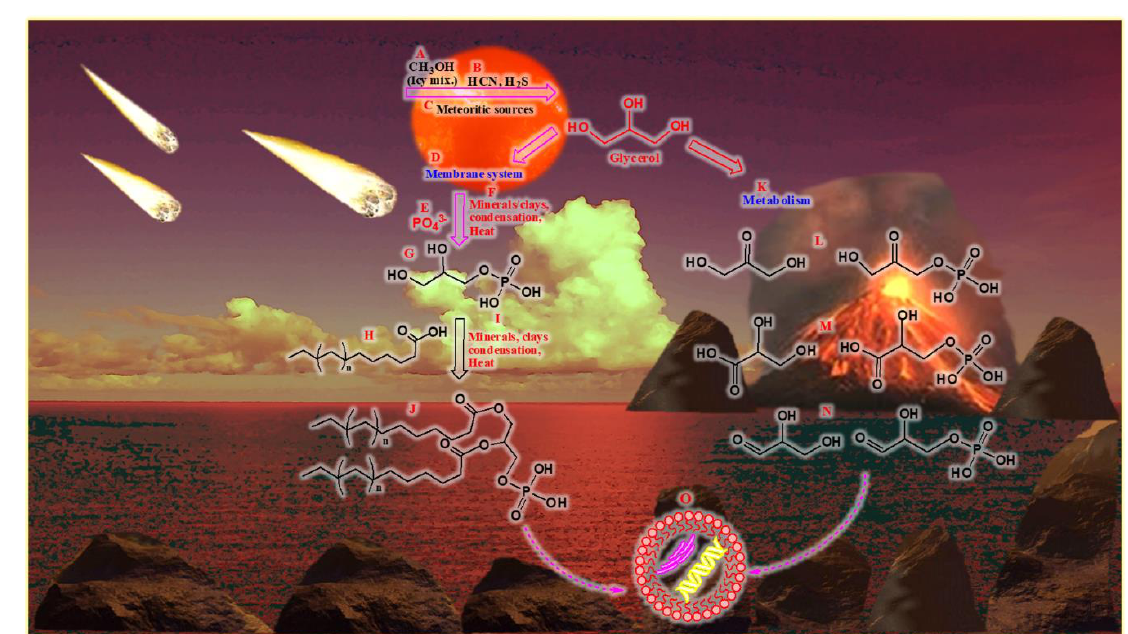
Figure 15. A schematic description of the plausible role played by glycerol during prebiotic synthesis and chemical evolution: ( A , B ) the prebiotic synthesis and origin of glycerol, ( C ) glycerol detection in meteorites, ( D ) the pathway by which glycerol is involved in the origin and development of cell membranes, ( E ) various phosphate sources employed in the phosphorylation reactions, ( F ) various minerals/clays employed in the phosphorylation, ( G ) formation of glycerol phosphates, ( H ) condensation reactions of glycerol phosphates with fatty acids, ( I ) specific minerals/clays used for the condensation reaction between glycerol phosphates and fatty acids, ( J ) formation of phospholipids, and ( K ) role of glycerol and its derivatives in various metabolic pathways The key derivatives include: ( L ) DHA and DHAP, ( M ) glyceric acid and phosphoglyceric acid, ( N ) glyceraldehyde and glyceraldehyde phosphate, respectively, and finally ( O ), an early developing cell on the early Earth, containing the metabolic molecules encapsulated by lipids/early cell membranes.